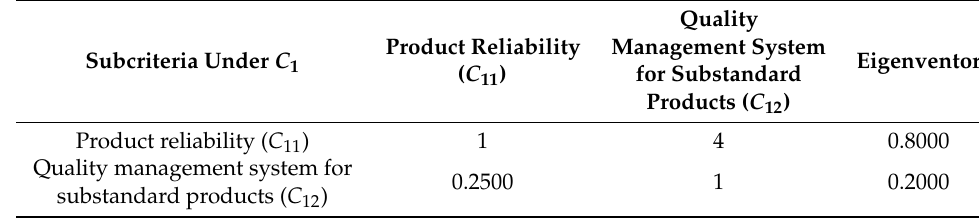
Table 6. Pairwise comparison matrix and eigenvector for subcriteria under criterion C 1 .